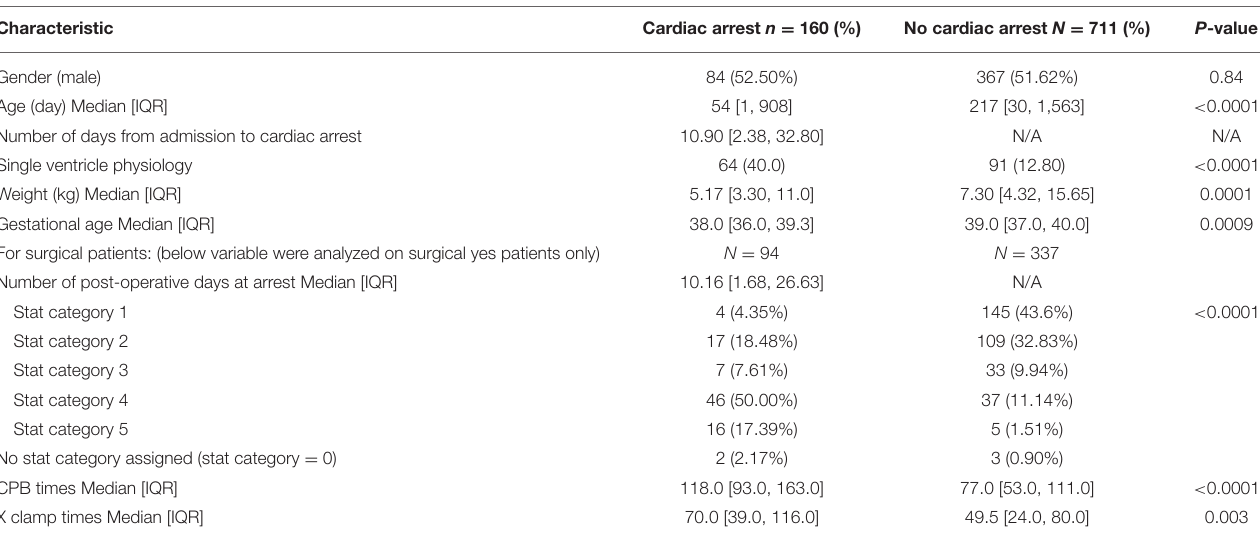
TABLE 3 | Patient prearrest characteristics: cardiac arrest vs. no cardiac